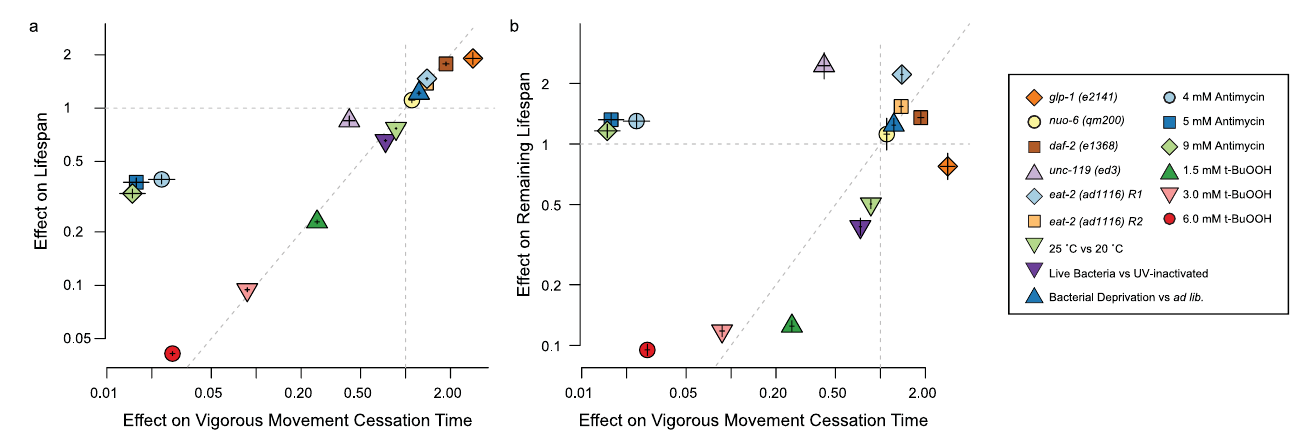
Fig 5. The relative effects of mutations and interventions on vigorous movement and lifespan. a. The effect of 15 interventions on vigorous movement, lifespan, and remaining lifespan are shown, with each point showing an interventions’ effect on VMC (x-axis) and lifespan (y-axis) or b. remaining lifespan (y- axis). Intervention effects are quantified as the fold-change in VMC times, death times, or remaining lifespan observed in the treated population relative to untreated controls (usually wild-type animals at 20˚C). The interventions tested were glp1(e2141) (orange diamond), nuo-6(qm200) (yellow circle), daf-2 (e1368) (brown square), unc-119(ed3) (light purple triangle), two replicates of eat-2(ad1116) : (blue diamond and orange square), the effect of exposure 25˚C throughout adulthood compared to the same period spent at 20˚C (green inverted triangle), the effect of a diet consisting of live E . coli compared to a diet of UV-inactivated E. coli (purple inverted triangle), bacterial deprivation (blue triangle), 4, 5, and 9 mM Antimycin A, (light blue circle, blue square, green diamond), and 1.5 mm, 3mM and 6 mM t-BuOOH (green triangle, pink triangle, red circle). Error bars indicate bootstrapped 95% confidence intervals.